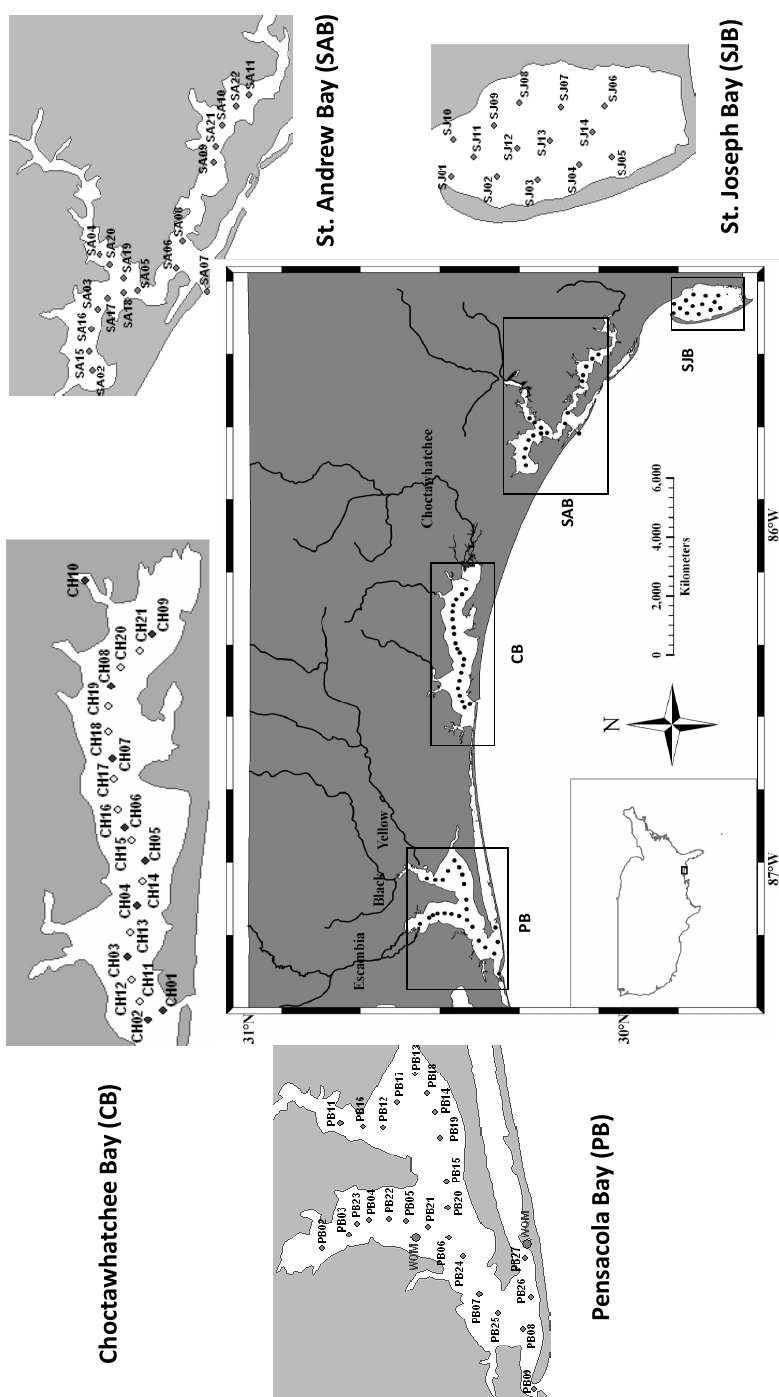
Figure 1. ( a ) Location of sampling stations within Narragansett Bay (NB), dark dots represent stations where in situ multi and hyperspectral measurements, conductivity, temperature, and depth (CTD) profiles, and water samples were collected.Not shown are three additional stations located along the length of the Providence River; ( b ) Location of sampling stations within Neuse River (NRE white dots represent stations where only hyperspectral data and water samples were collected. Salinity data were collected by the NCDENR/UNC FerryMon Project (dashed lines ( c ) Station locations in Pensacola, Chocowhatchee, St. Andrews, and St. Joseph Bays in the Gulf of Mexico, above-water hyperspectral measurements, CTD, and water samples are indicated as gray and white diamonds. WQM stations represent locations where only above-water hyperspectral and CTD measurements were